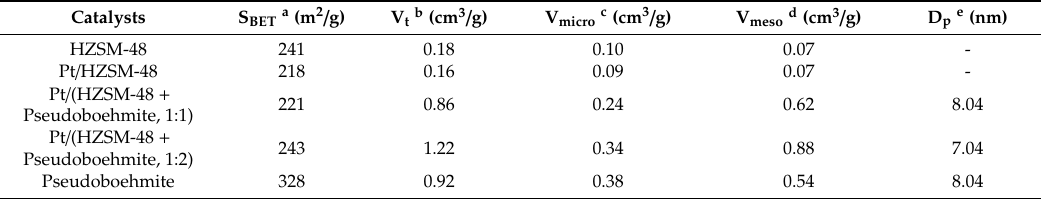
Table 1. Surface area, pore volume and average pore diameter of various